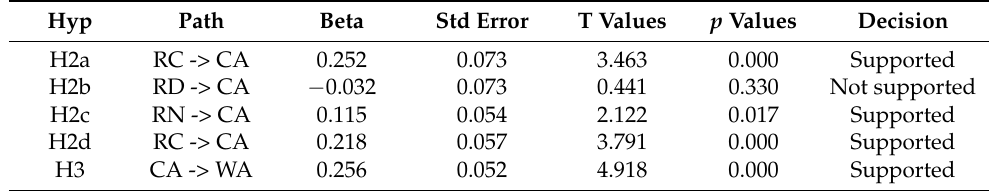
Table 10. Direct Hypotheses